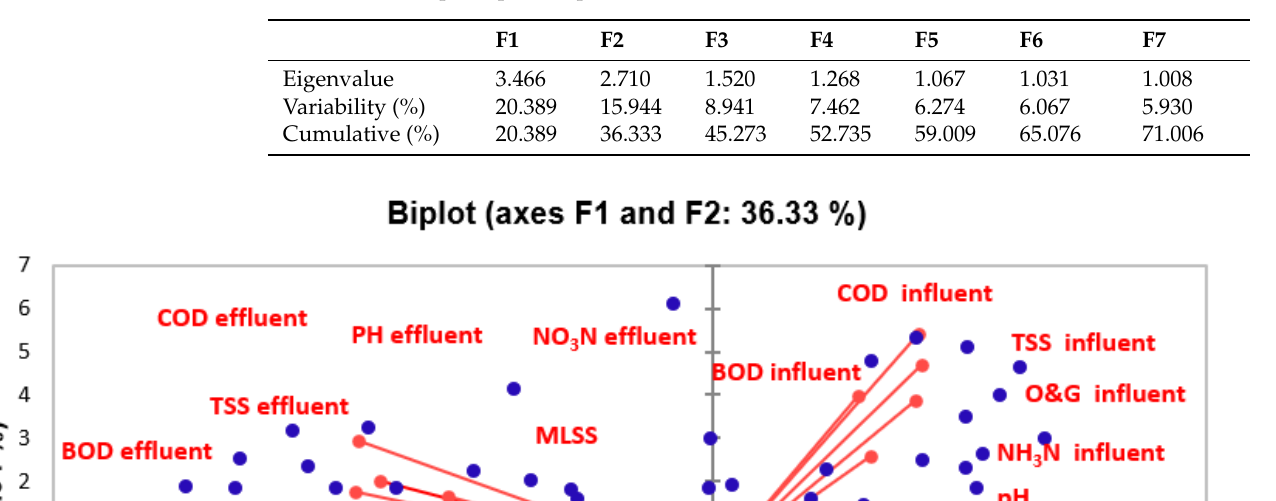
Table 3. Selected principal components with PCA.